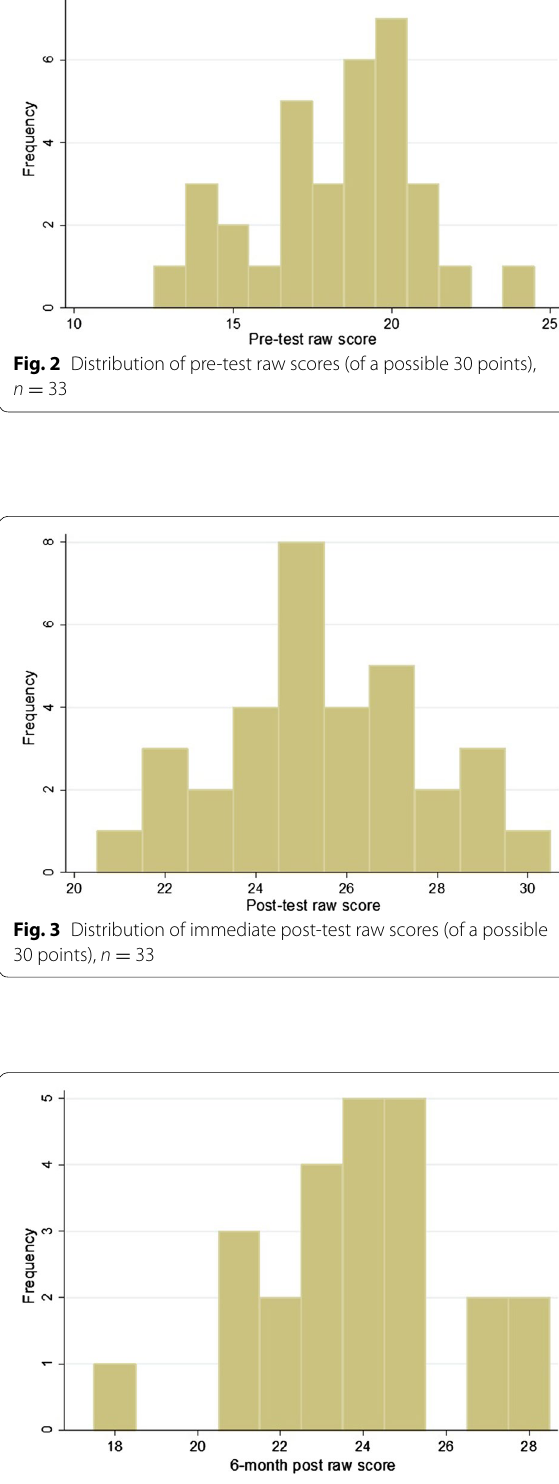
Fig. 4 Distribution of 6-month post-test raw scores (of a possible 30 points), n =